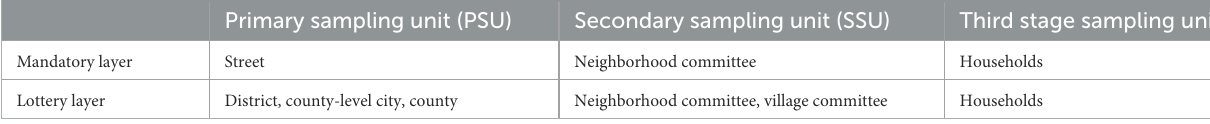
TABLE 1 Stratified three-stage probability sampling.